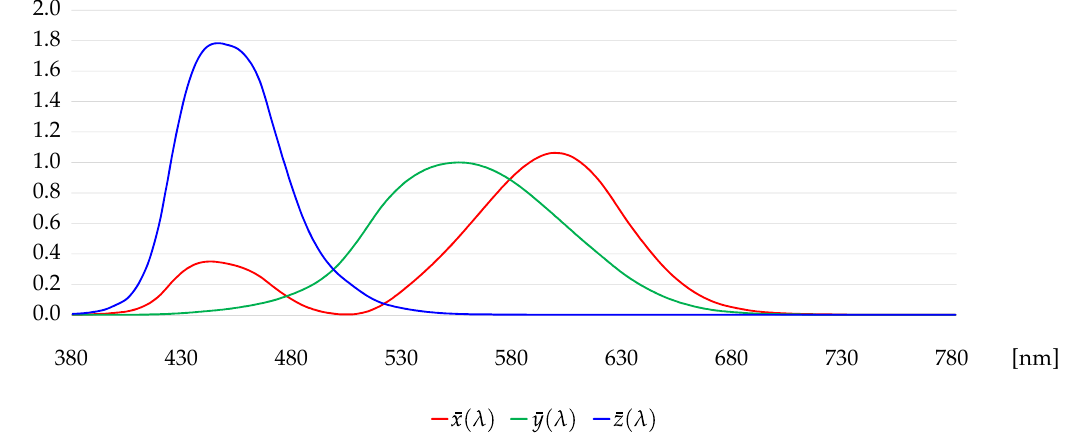
Figure 4. The CIE color matching functions ¯ x ( λ ) , ¯ y ( λ ) , ¯ z ( λ )